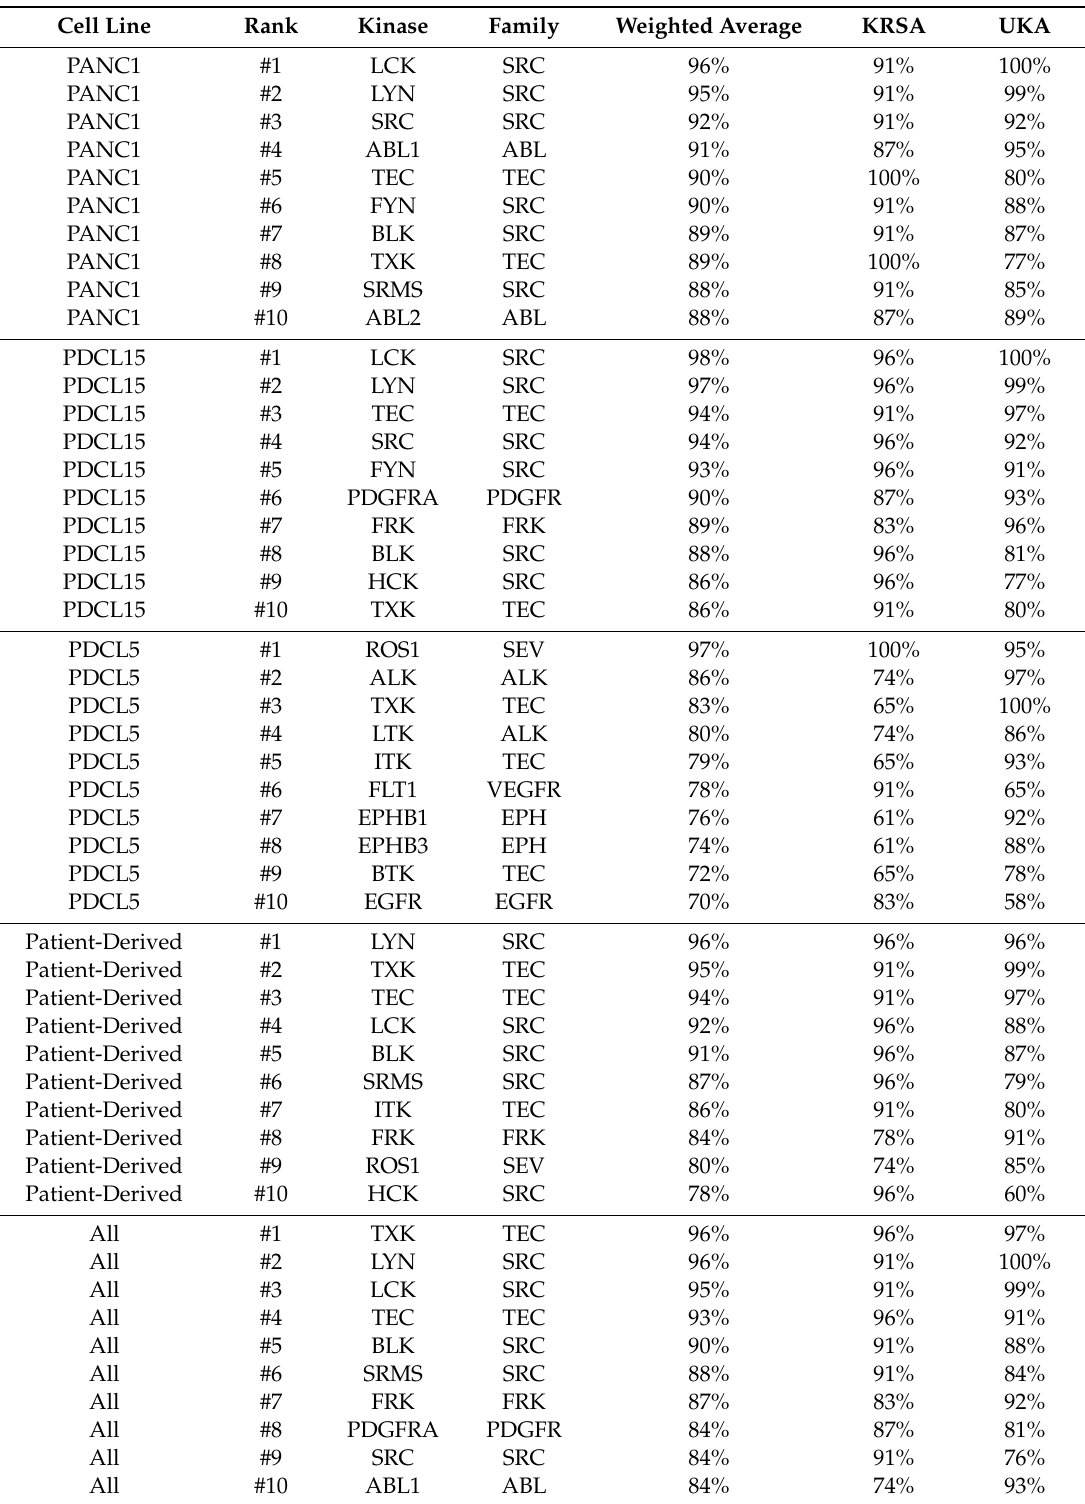
Table 2. UKA and KRSA weighted average percentile